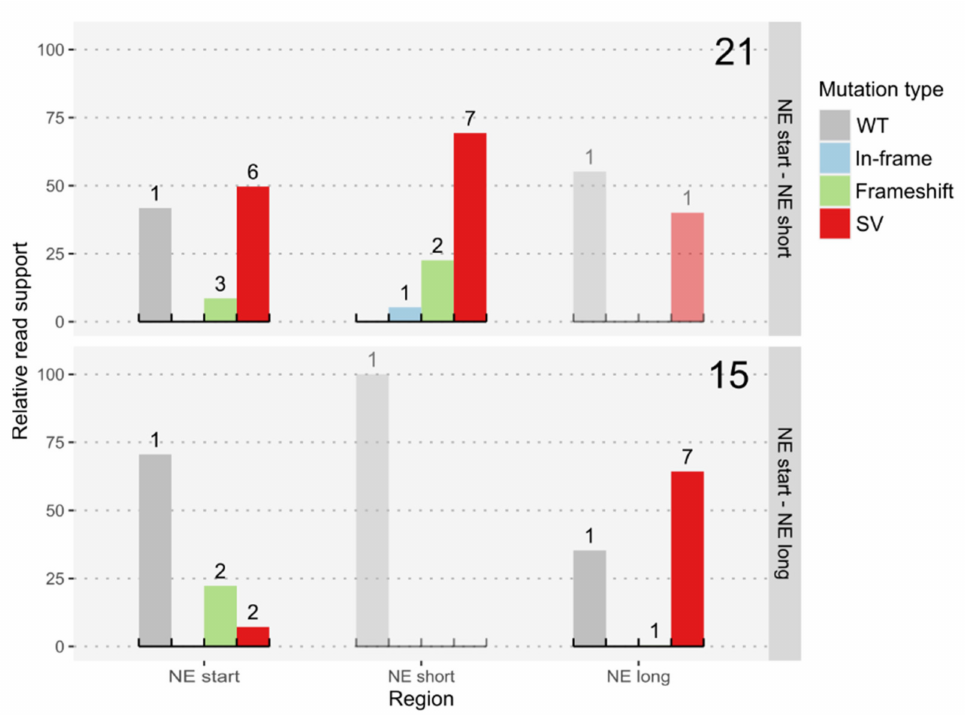
Figure 4. Relative read support for different mutation types at CRISPR/Cas9 targets in the strain K. phaffii BSYBG10_chr3ne_HygR. Large numbers on the right upper corners denote the number